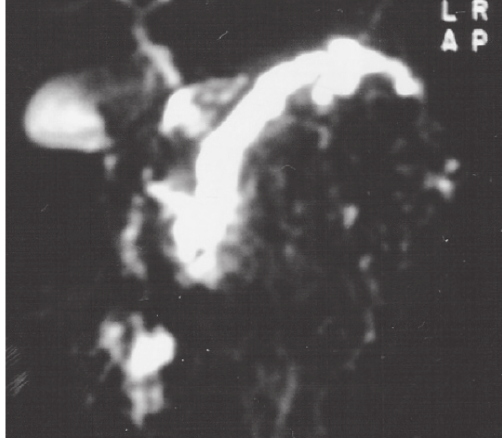
Figure 2- Magnetic resonance cholangiopancreatography with exogenous administration of secretin showing both the ventral duct and the dorsal pancreatic duct without connection between them. Santorini’s duct is slightly enlarged. The pancreas presents reduced dimensions and irregular borders compatible with a chronic inflammatory process.